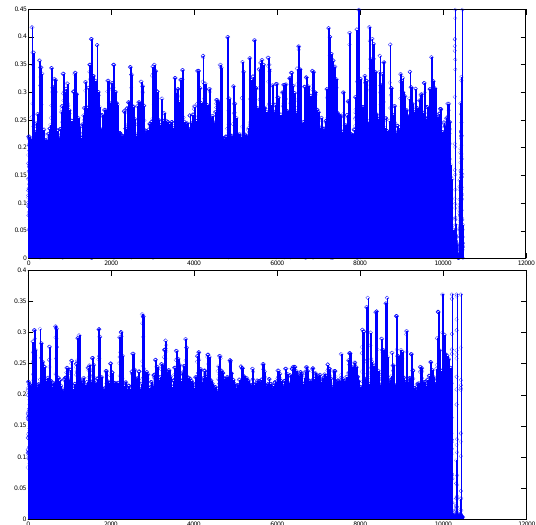
Figure 3. Visualiation of HOG features in three scale images